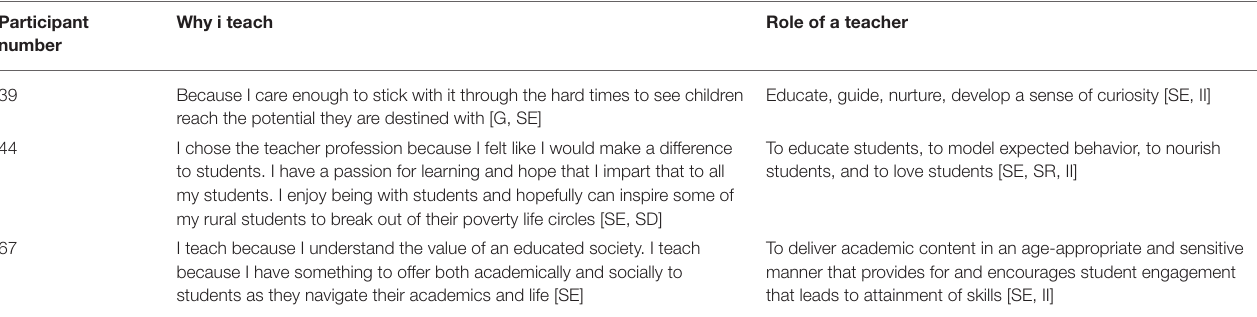
TABLE 7 | Responses from the same participant to our two free response items with attribute